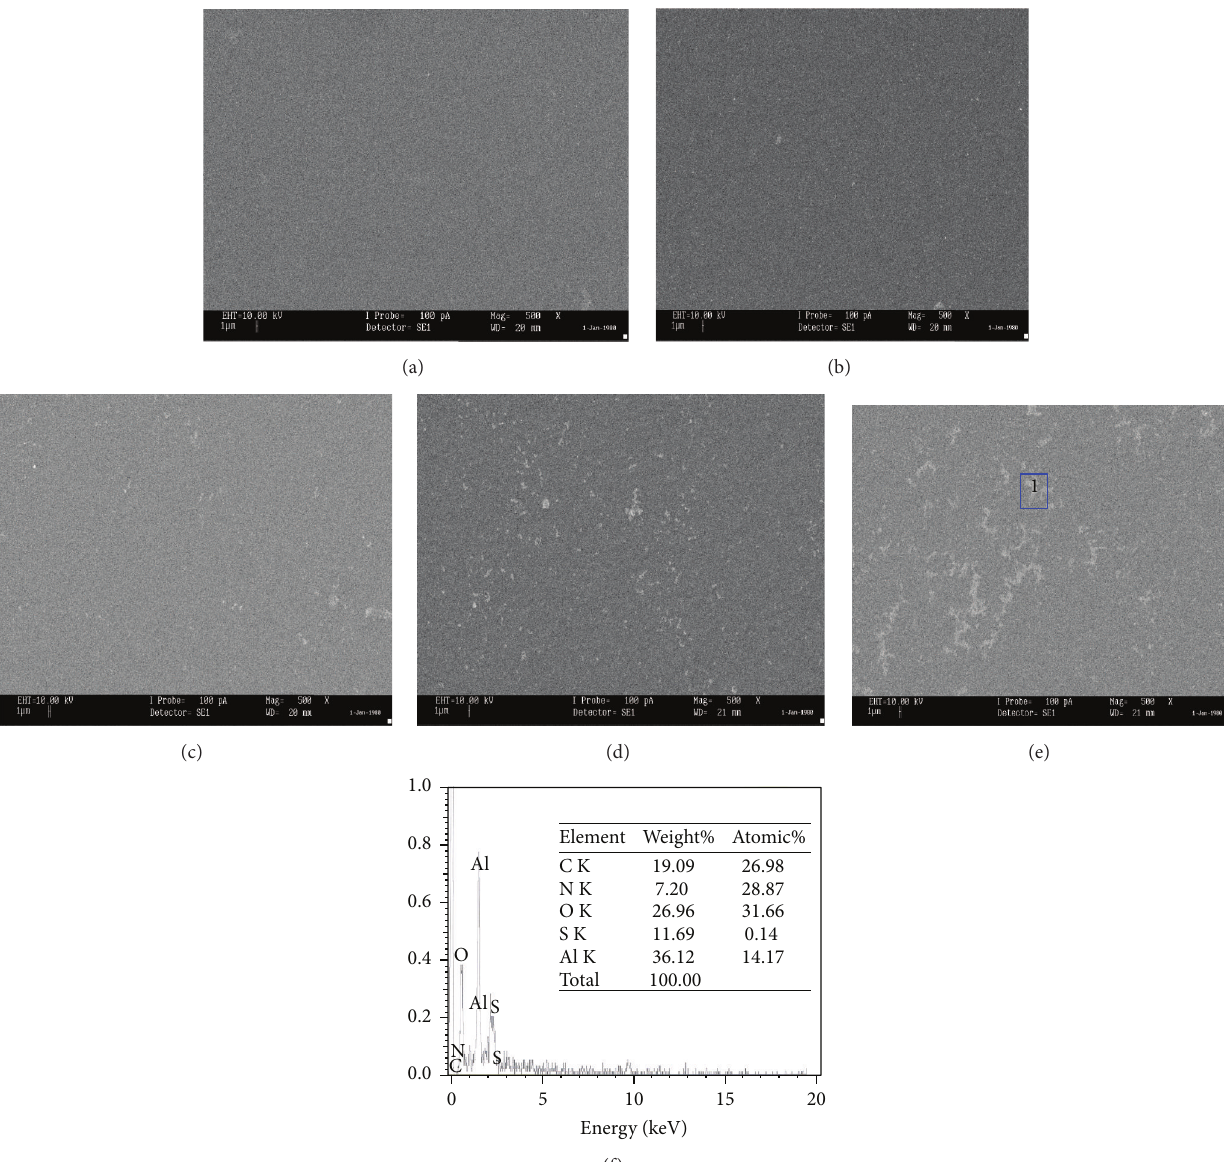
Figure 6: Scanning electron microscopy (SEM) image for (a) CSNC1, (b) CSNC2, (c) CSNC3, (d) CSNC4, (e) CSNC5, and (f) EDX for spot in box